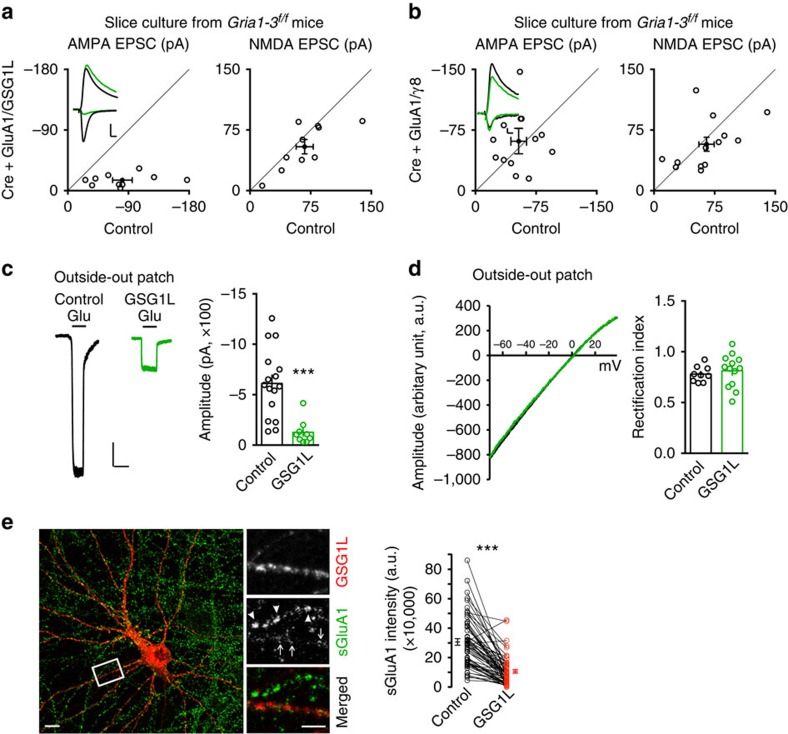
Overexpression of GSG1L impaired AMPAR trafficking to synaptic and
extrasynaptic membranes.(a,b) While GluA1/γ8 fully rescued AMPA EPSCs (b,
AMPA, n=13; P=0.51; paired t-test; Scale
bar, 20 pA and 20 ms), GluA1/GSG1L (a, AMPA,
n=10; P<0.01; paired t-test; Scale bar,
50 pA and 20 ms) only rescued ∼20% of AMPA EPSCs in
CA1 pyramidal neurons expressing Cre in cultured organotypic hippocampal
slices prepared from Gria1–3f/f mice.
(c) Overexpression of GSG1L strongly reduced AMPAR-mediated
somatic outside-out patch currents induced by 1 mM glutamate in the
presence of 100 μM cyclothiazide (control, n=16;
GSG1L, n=9; P<0.001; t-test). Scale bar,
100 pA and 2 s. (d) Left panel shows sample traces of
normalized I/V curves recorded from glutamate-evoked somatic
outside-out patch currents in control and GSG1L-overexpressing CA1 pyramidal
neurons in cultured organotypic slices. Bar graph shows that there is no
difference of the rectification index (control, n=9; GSG1L,
n=13; P=0.57; t-test). (e)
Expression of GSG1L-Myc strongly reduced surface GluA1 expression in
cultured dissociated hippocampal neurons. (Left) Representative image of
cultured hippocampal neurons (DIV17) expressing Myc-tagged GSG1L (red), and
stained for surface GluA1 (green). Scale bar, 10 μm. The boxed
area was shown in the middle. (Middle) Arrow heads indicate the surface
expression of GluA1 (sGluA1) on a Myc-tagged GSG1L-negative dendrite and
arrows indicate the surface expression of GluA1 on a Myc-tagged GSG1L
positive dendrite. Scale bar, 5 μm. (Right) Scatter plot
represents the distribution of each pair of cells analysed and shows that
GluA1 surface expression on Myc-tagged GSG1L positive dendrites
(GSG1L) was significantly reduced (n=6 independent cultures
and 64 pairs of neighbouring neurons; P<0.001, t-test with
n=64; P<0.01, t-test with
n=6; P<0.01 with two-level nested ANOVA).
Statistical significance is presented as
***P<0.001.